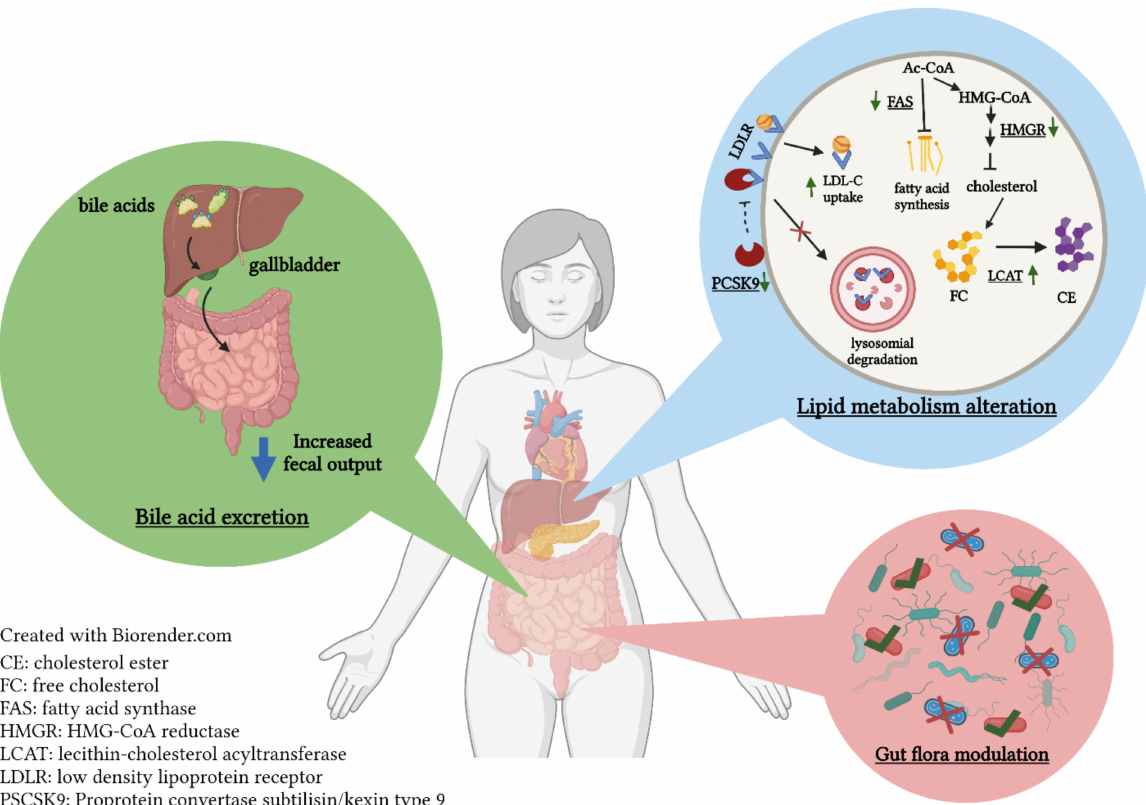
Figure 2. The mechanisms of action in which plant protein alters lipid